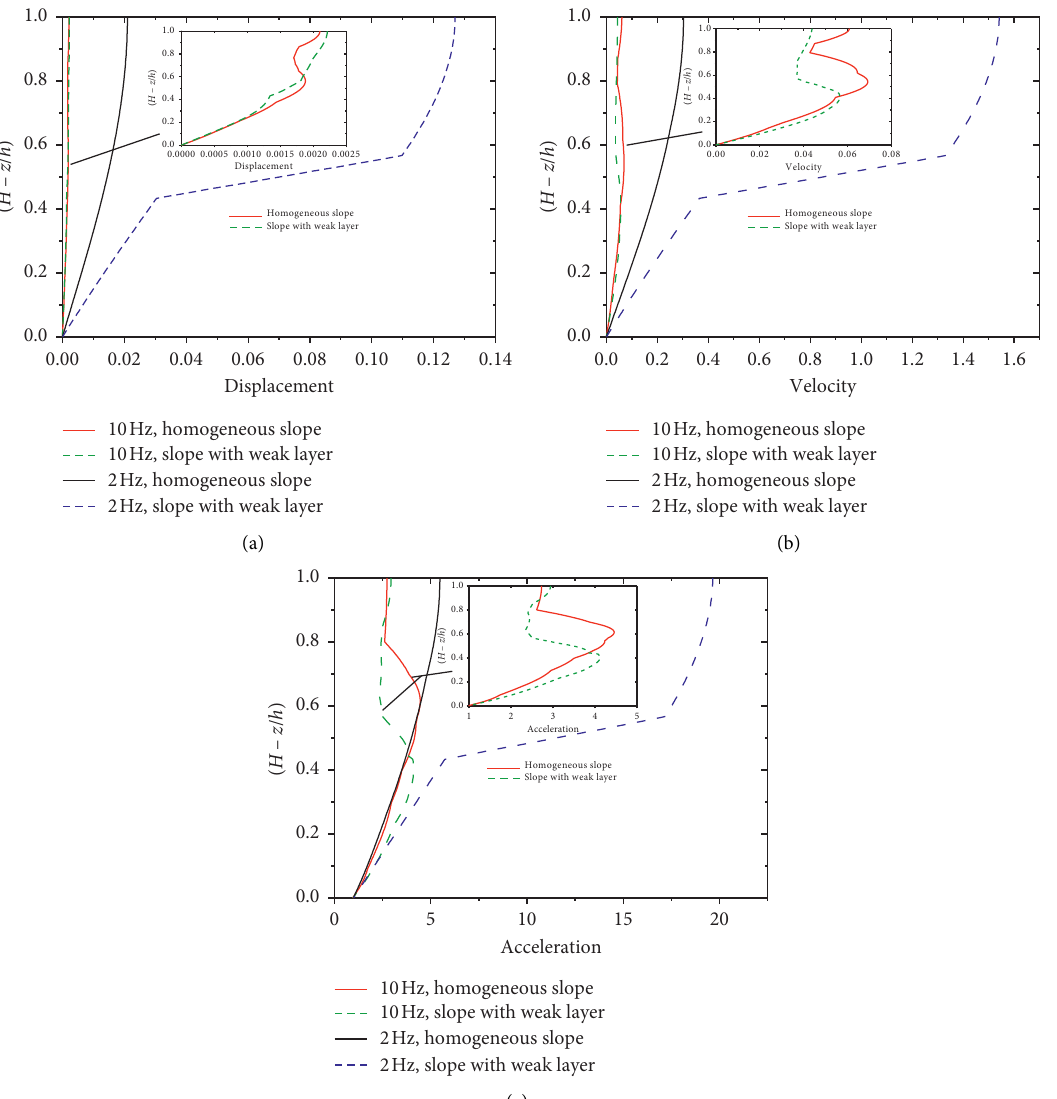
Figure 11: Dynamic responses at low and high frequencies. (a) Displacement. (b) Velocity. (c)